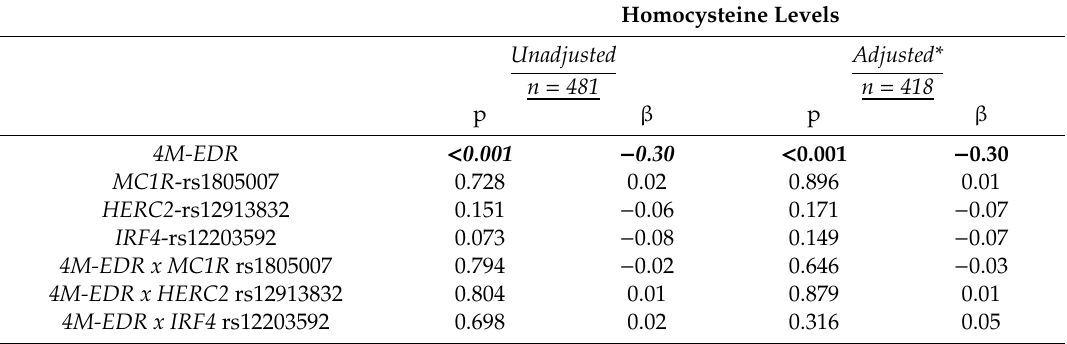
Table 9. Interactions between 4M-EDR and skin pigmentation variants in predicting homocysteine